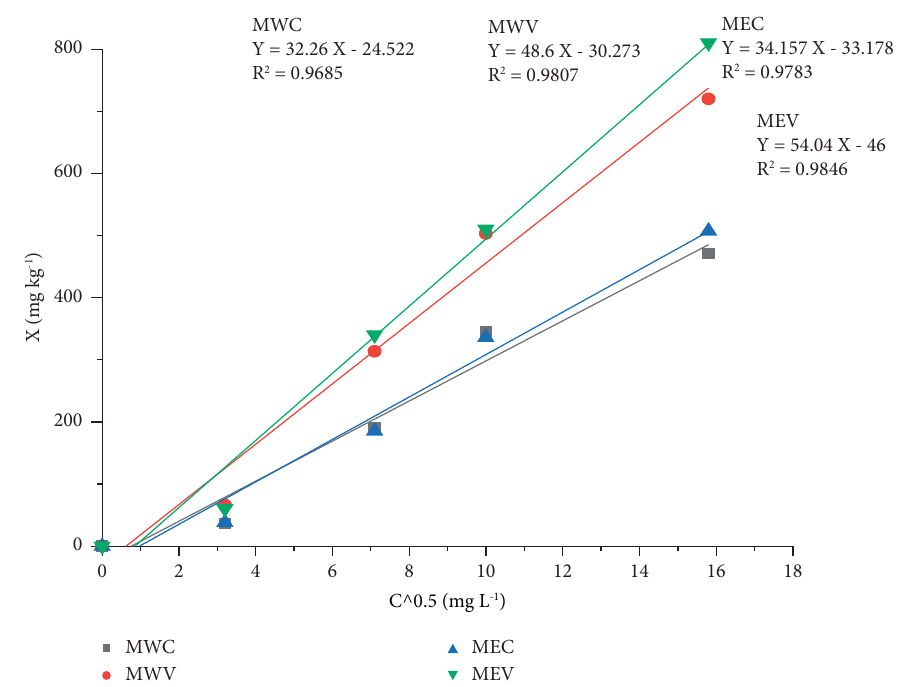
Figure 5: Linear Van Huay isotherm for the soil of Meupi (24hours equilibration at 25 ° C).